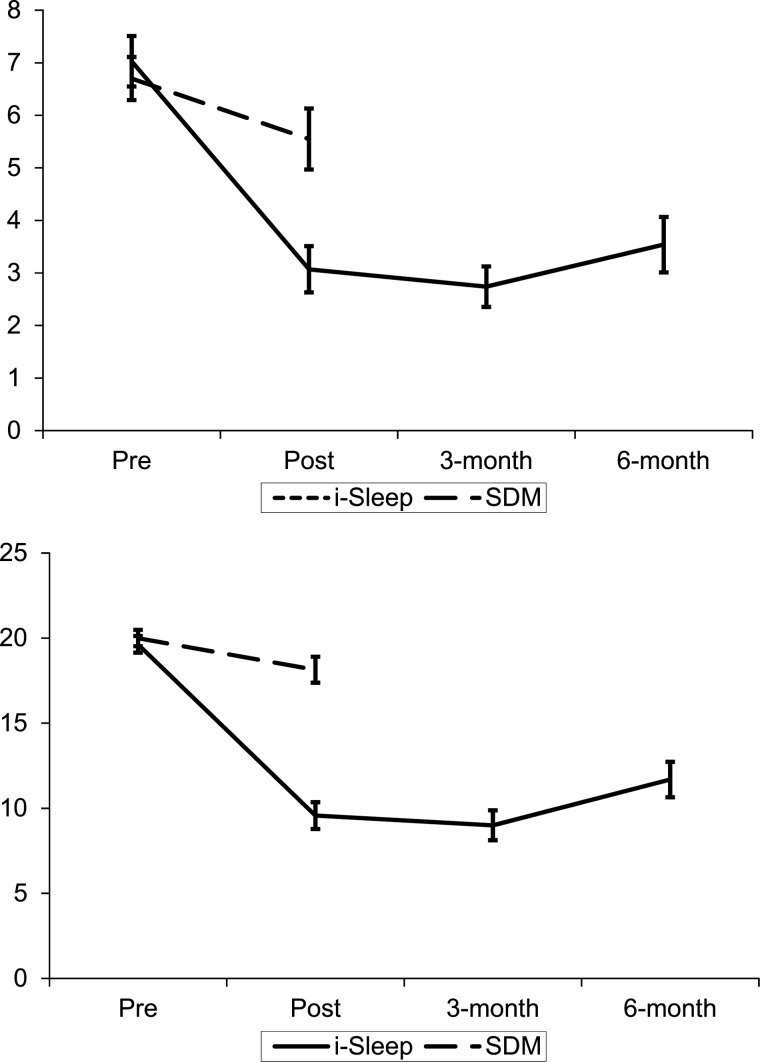
Mean PHQ-WS and ISI in both conditions at pre- and post-assessment and FU for i-Sleep condition. Note: Error bars represent 95% confidence intervals. PHQ-WS, Patient Health Questionnaire 9 minus the sleep item; ISI, Insomnia Severity Index; I-Sleep, online CBTI treatment; SDM, Sleep Diary Monitoring.